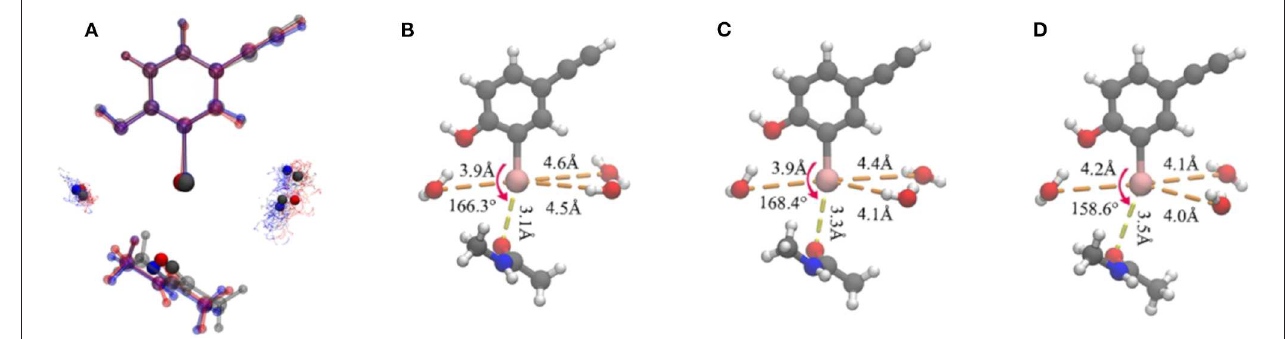
FIGURE 5 | Representation of the clustering results. (A) Superposition of the three representative structures of each cluster in a ball-and-stick model. It is worth noting that the iodine atom, the oxygen atoms in the three water molecules, and the oxygen atom in the protein that formed a halogen bond are seen in the opaque material. The oxygen atoms in the water molecules in each cluster are shown as points. Color code: red, cluster A; gray, cluster B; blue, cluster C. The simplified representative structure of cluster A (B) , cluster B (C), and cluster C (D) , saturating the broken bond with hydrogen atoms. The values of the five clustering descriptors are indicated.